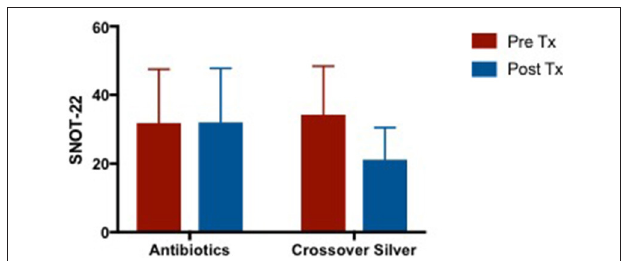
FIGURE 6 | Bar graph comparing SNOT-22 scores of patients following failed culture sensitive oral antibiotics and crossed-over to CS treatment. SNOT-22, Sino-Nasal Outcome Test-22; CS, Colloidal silver.